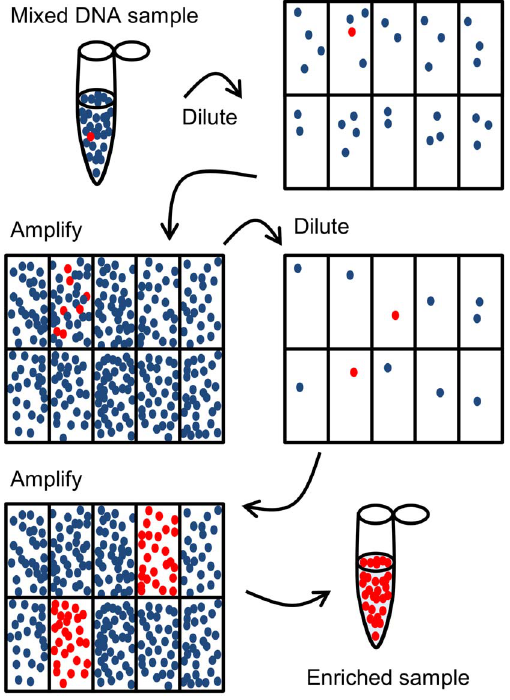
Figure 1. The principle behind the PINS enrichment is a repetition of the steps of end-point dilution and general amplification. The mixed DNA sample is diluted until less than one out of 5–10 wells contain the target DNA molecule to be enriched and the DNA in all wells is then generally amplified using Phi29 polymerase. A sample containing target DNA is selected for next round of dilution and general amplification based on the result of qPCR directed towards the